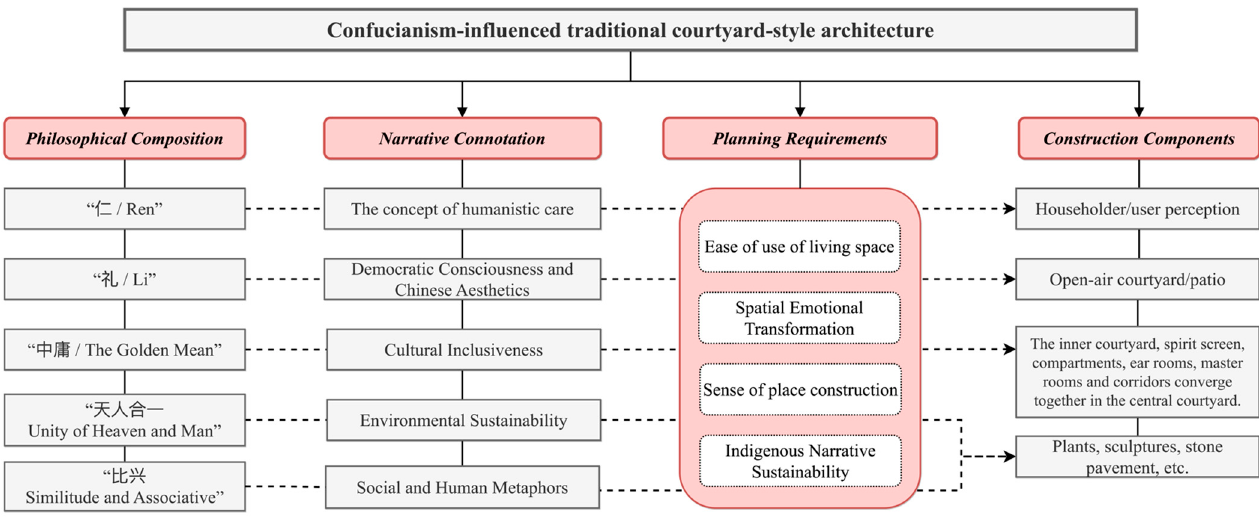
Figure 9. Confucianism and relation of traditional courtyard-style architecture components.